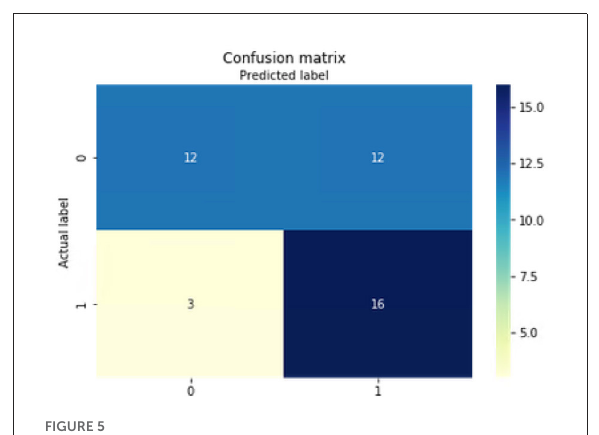
FIGURE5 Confusion matrix for our headlines